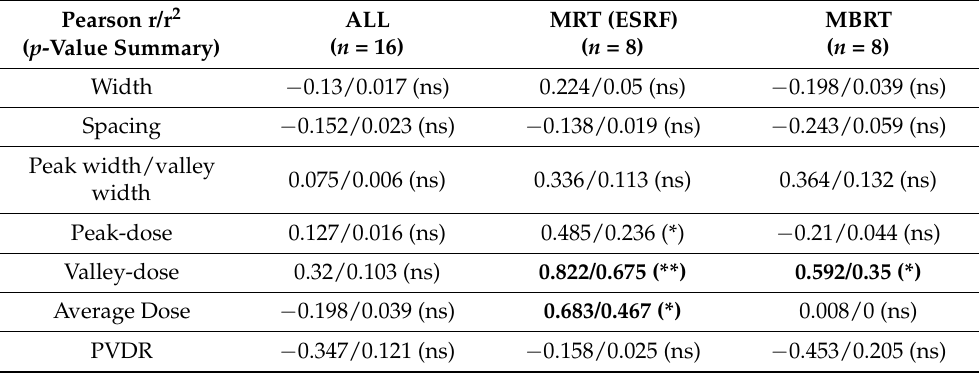
Table 3. Correlation coefficients of ILS versus the several dosimetry and geometrical parameters considered in this study. The group “ALL” includes all preclinical SFRT parameters (variables) selected in this study, which are presented in Tables 1 and